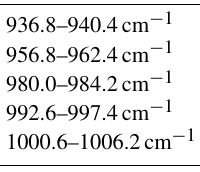
Table F1. Spectral regions used for the O 3 retrieval (0.2cm − 1 res-